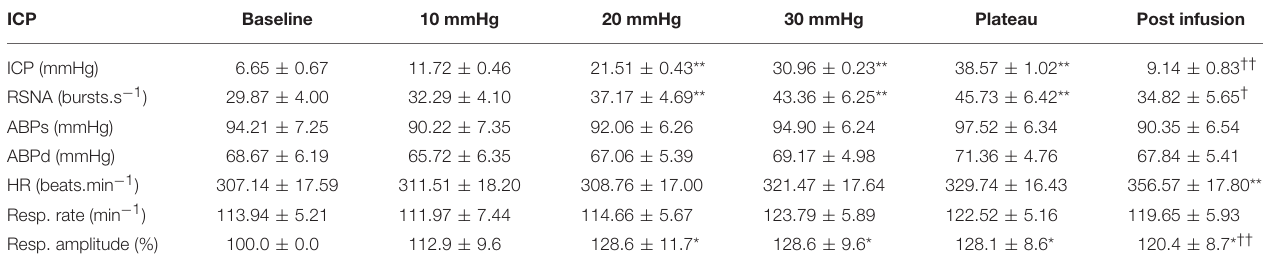
TABLE 1 | Results of sympathetic activity and systemic parameters during modest ICP increase and decrease in animal ( n =